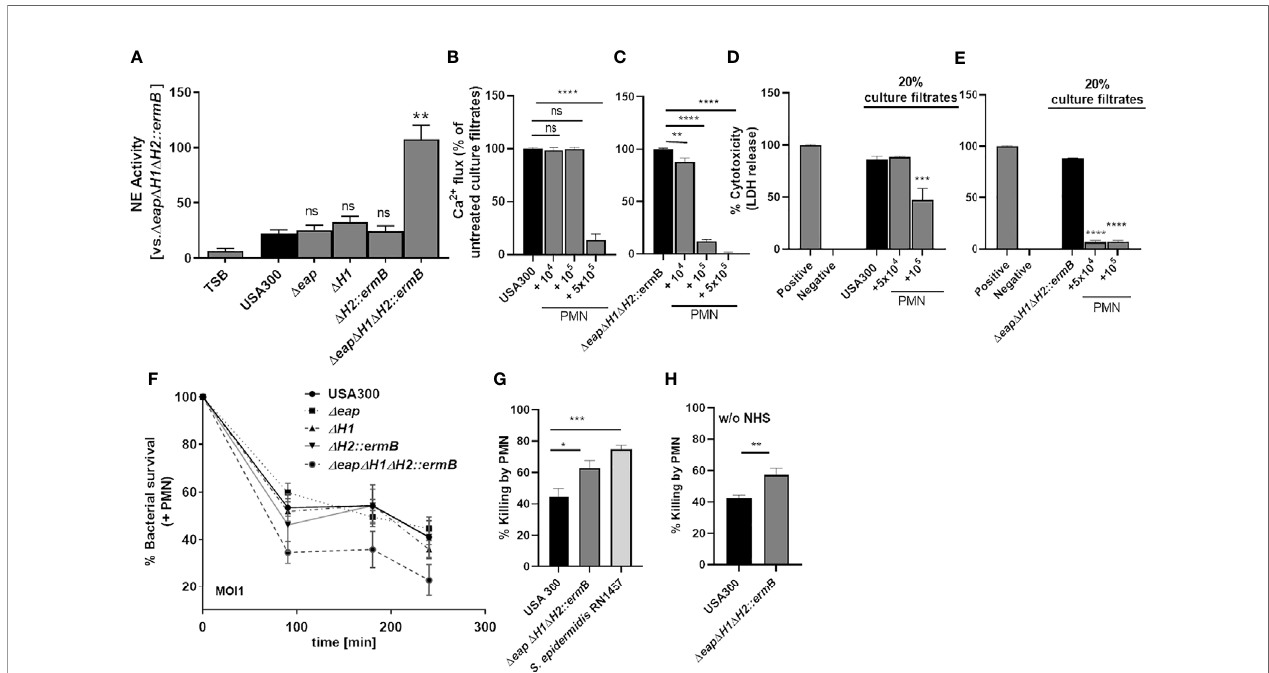
FIGURE 6 | The combined deletion of the three NSP inhibitors enhances inactivation of PSMs by neutrophils in culture fi ltrates of USA300 and lead to enhanced killing of S. aureus. Incubation of neutrophils with bacterial culture fi ltrates of USA300 and isogenic triple-NSP inhibitor mutant induces release of NE. Inactivation of all three NSP inhibitors strongly enhances NE activity, whereas single knock outs do not (A) . Incubation of neutrophils for 24 h with USA300 or USA300 D eap D H1 D H2::ermB leads to enhanced inactivation of FPR2 activity (B, C) and cytotoxicity (D, E) of the NSP inhibitor mutant compared to the wild type. The deletion of all three NSP inhibitors but not of a single NSP inhibitor impairs survival of S. aureus in the presence of neutrophils (F) . Killing of S. aureus USA300 compared to isogenic triple-NSP inhibitor mutant and S. epidermidis (G) . Data represent means ± SD of at least three independent experiments. ns, not signi fi cant, *P < 0.05; **P < 0.01; ***P < 0.001; ****P < 0.0001 signi fi cant difference versus USA300 (A, G, H) or untreated controls (B – E) as calculated by one-way ANOVA with Dunnett ’ s multiple comparisons test (A – G) or unpaired Students t-test (H)